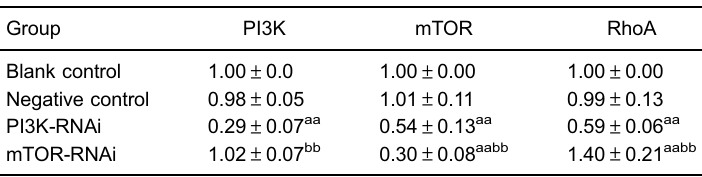
Table 1. mRNA relative expression levels of PI3K, mTOR, and RhoA in each group (mean ± SD). Group